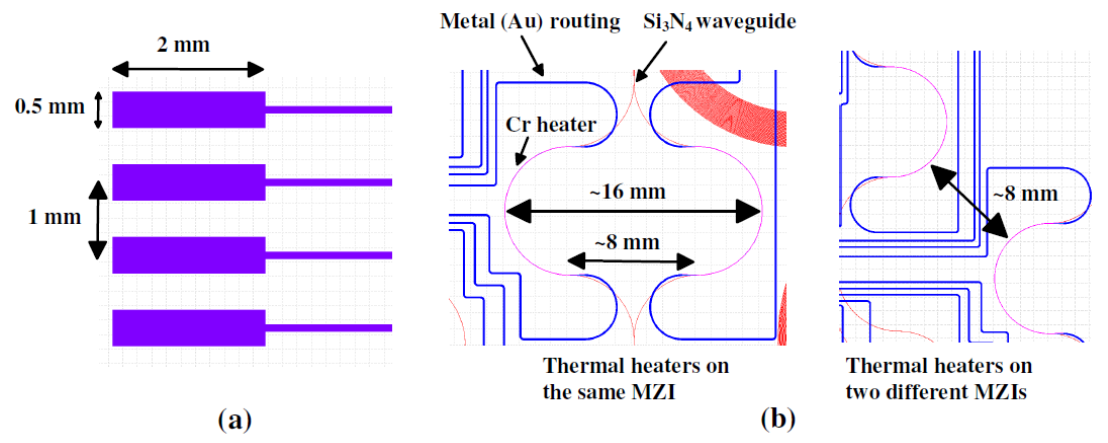
Figure 6. ( a ) Dimension and vertical separation between the electrical contact pads, ( b ) Layout of the thermal heaters, minimum distance is kept to 8 mm to avoid thermal